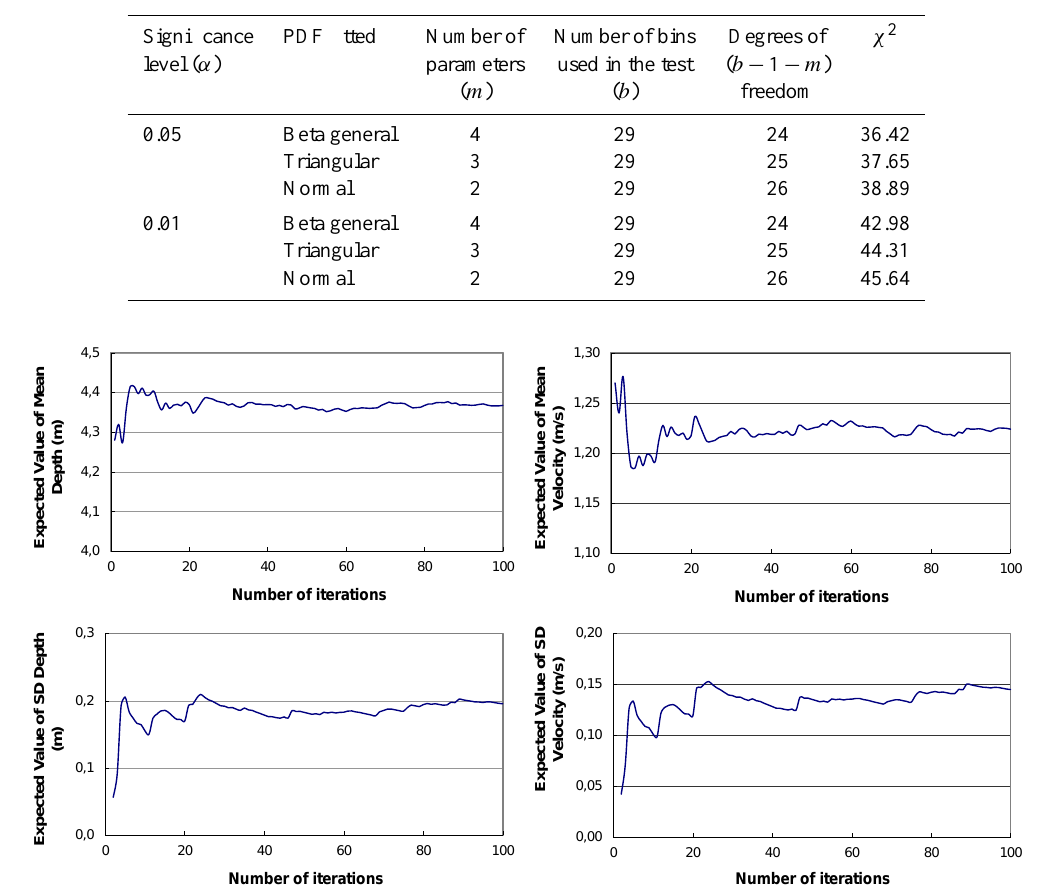
Fig. 7. 1-D HEC-RAS model. Convergence of mean and standard deviation values for water depth and velocity at RS 768. Case of n i uniformly distributed with flow case 500m 3 s − 1 .